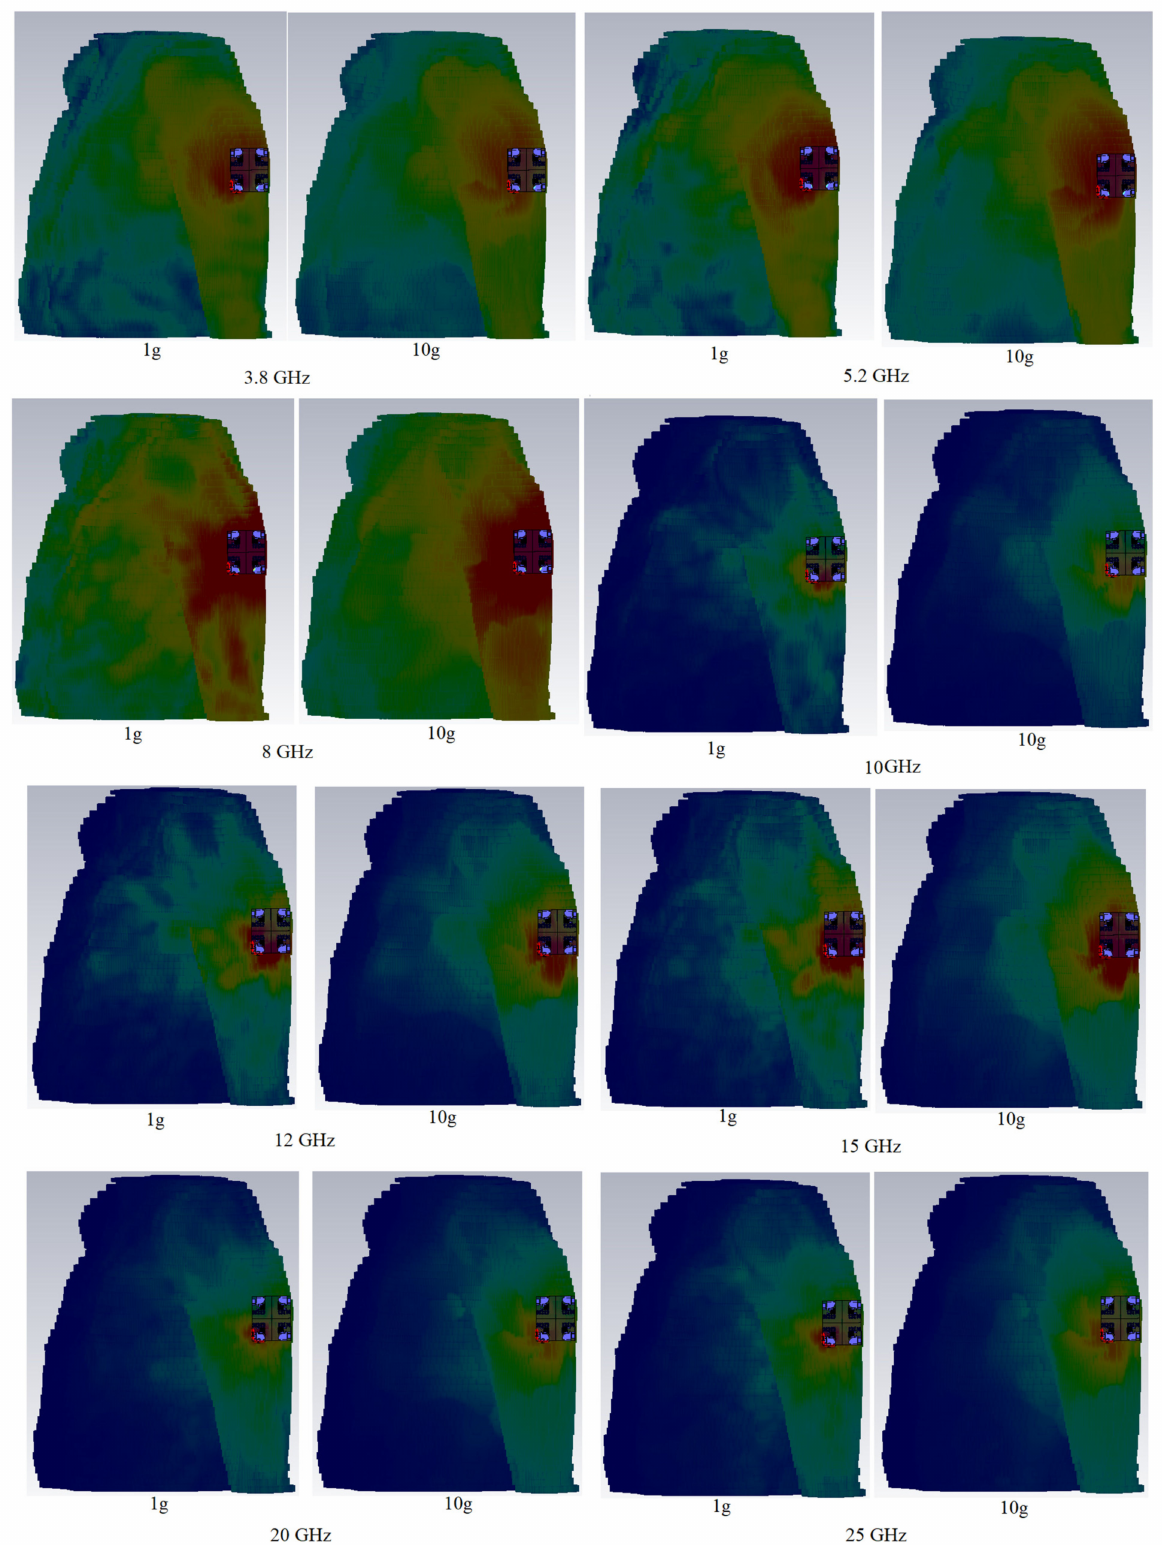
Figure 29. Simulated SAR distribution for the MIMO antenna on arm at different frequencies. More simulations were run to see how well the suggested MIMO antenna worked when held close to the CST MWS human arm and chest voxel model. When port 2